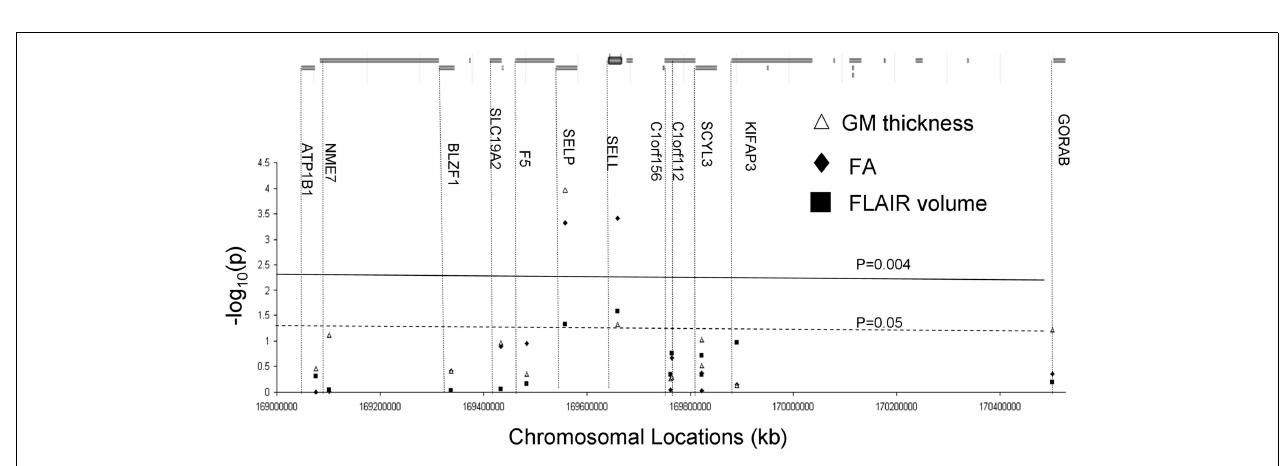
FIGURE 2 | Skeletonized, average FA values are shown on the population average FA image. WM tract labels for nine major tracts are taken from the Johns Hopkins DTIWM atlas.The average FA values were calculated for the following tracts: corona radiata (CR), superior longitudinal fasciculus (SLF), cingulate, external capsule (EC), internal capsule (IC), fronto-occipital (FO),